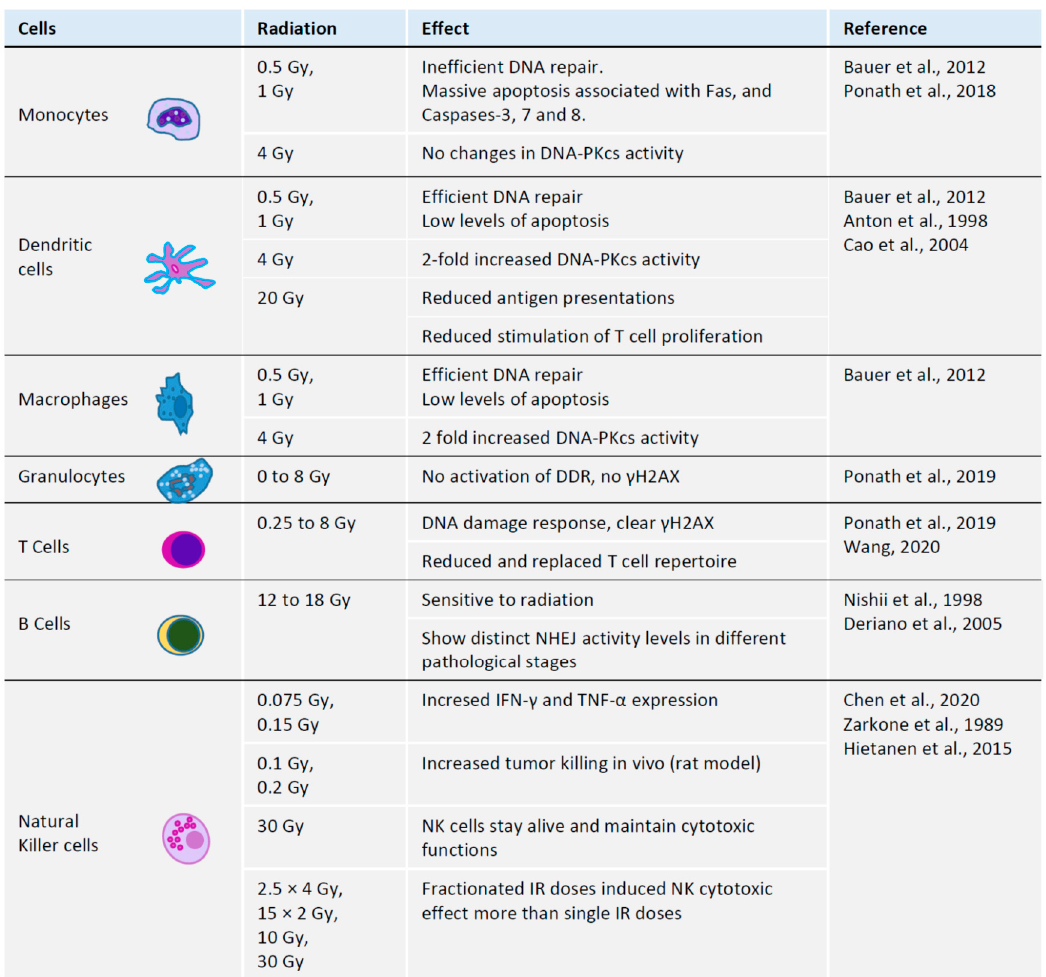
Figure 2. Impact of radiation on monocytes, dendritic cells (DC), macrophages, granulocytes, T cells and natural killer (NK) cells in human model systems, unless specified otherwise. Indicated irradiation doses are in range of clinically-relevant doses, depending on the regimens. References to the Figure